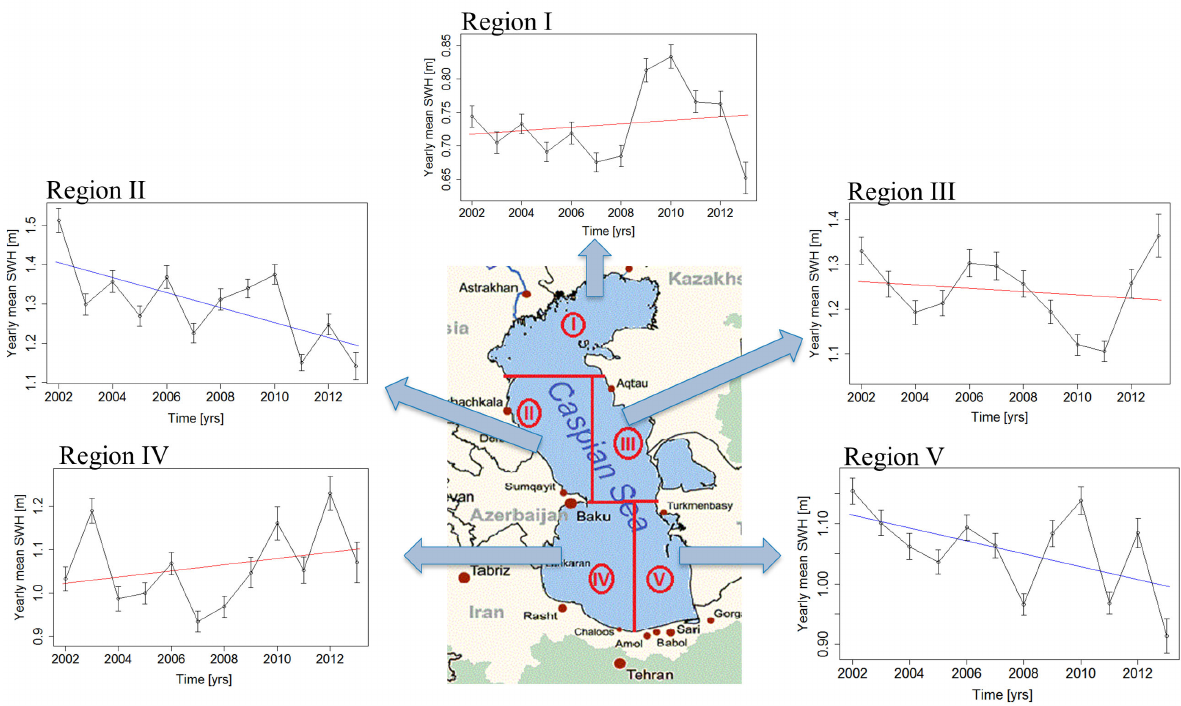
Fig. 9. Variations in the annual mean significant wave height (SWH) for five regions of the Caspian Sea. The solid red lines show linear trends (regression lines) that are statistically not significant. The solid blue lines show trends that are nonzero at a >95% level of statistical significance. The shown uncertainty is inversely proportional to the number of measurements per year: the lower is the number of measurement, the higher is